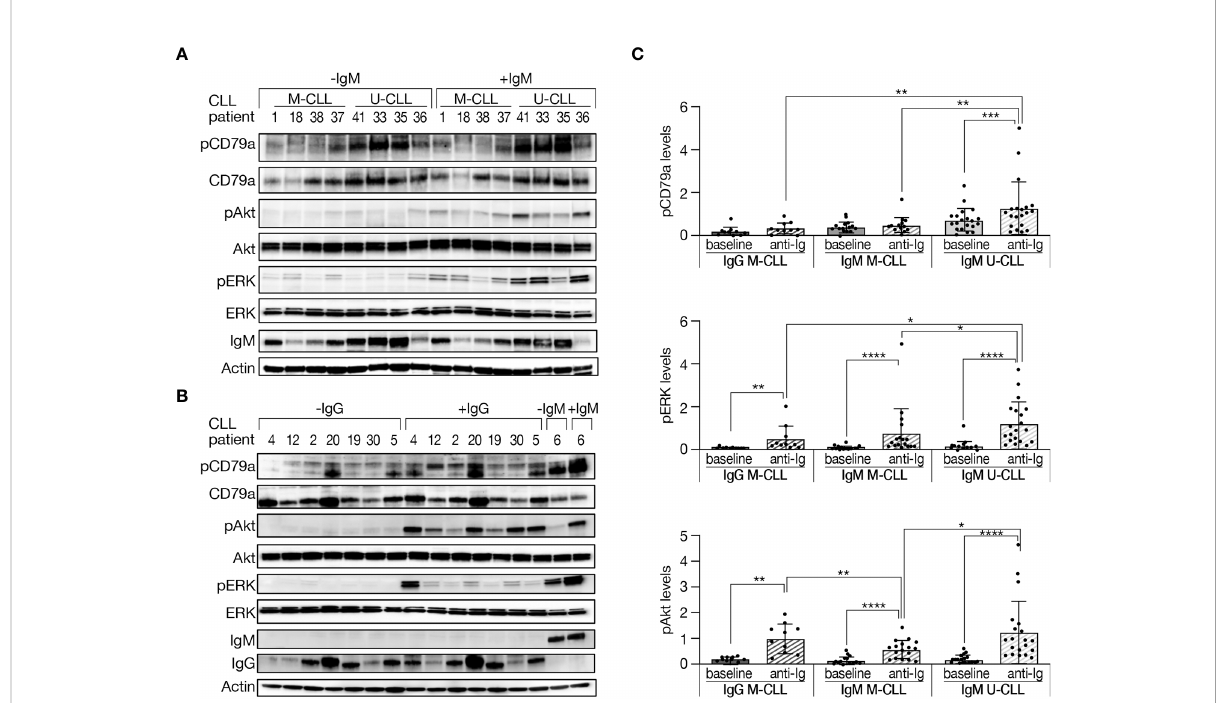
FIGURE 3 Phosphorylation levels of BcR signaling elements in M-CLL and U-CLL cells after BcR activation. (A, B) Peripheral blood CLL cells were incubated with goat F(ab ′ )2 anti-human IgM or with goat F(ab ′ )2 anti-human IgG (10 µg/ml) for 15 min or left untreated. Protein was extracted and analyzed by Western blot. A representative Western blot analysis showing CD79a (Y182), Akt (S473), and ERK (T202/Y204) phosphorylation, as well as total amount of these proteins, and IgM and IgG levels. Actin was used to verify equal loading. (C) Quanti fi cation of pCD79a, pAkt, and pERK levels in activated and inactivated CLL cells in (A, B) by normalization to actin using the myImageAnalysis ™ Software. (n = 47).*p < 0.05, **p < 0.01, ***p < 0.001, and ****p <